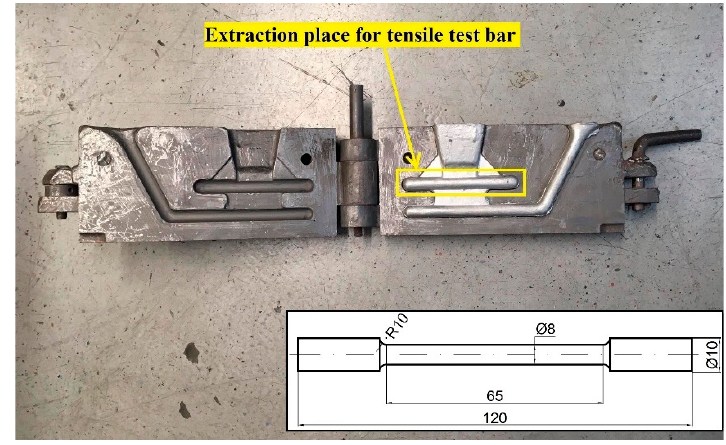
Figure 3. Metal mold with scheme of the tensile test bar .